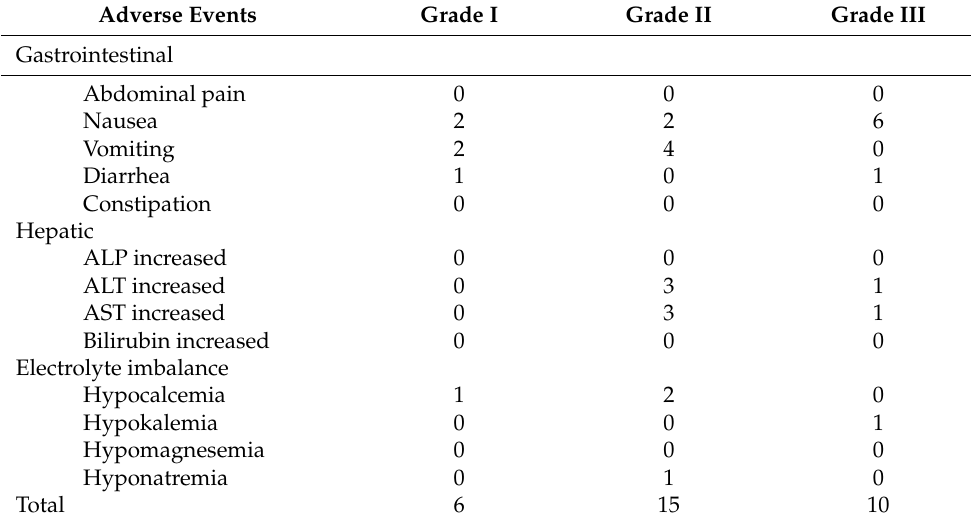
Table 2. Non-hematologic adverse events during study protocol in 112